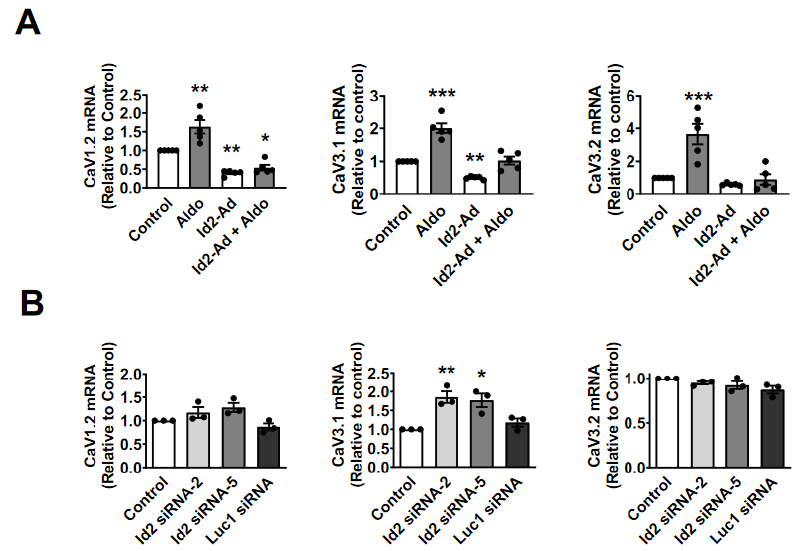
Figure 3. Manipulation of Id2 ′ s expression altered of voltage-gated calcium channel expression in neonatal rat ventricular cardiomyocytes and prevented aldosterone-stimulated increased. ( A ) 2, CaV3.1, and CaV3.2 were measured by RT-qPCR in neonatal rat ventricular cardiomyocytes treated and non-treated with 1 µ mol/L Aldo for 24 h upon Id2 overexpression. Bar graphs shows the mean expression of CaV1.2 mRNA (left), CaV3.1 mRNA (middle), and CaV3.2 (right) ( n = 5). ( B ) The mRNA expression of CaV1.2, CaV3.1, and CaV3.2 were measured by real-time qPCR in neonatal rat ventricular cardiomyocytes treated with Id2 siRNA-2, siRNA-5 or Luciferase1 siRNA for 48 h. Bar graphs shows the mean expression of CaV1.2 mRNA (left), CaV3.1 mRNA (middle), and CaV3.2 (right) ( n = 3). The data were evaluated by one-way analysis of variance (ANOVA) followed by Tukey–Kramer’s post hoc test. Data are the mean ± s.e.m, * p < 0.05, ** p < 0.01. *** p <